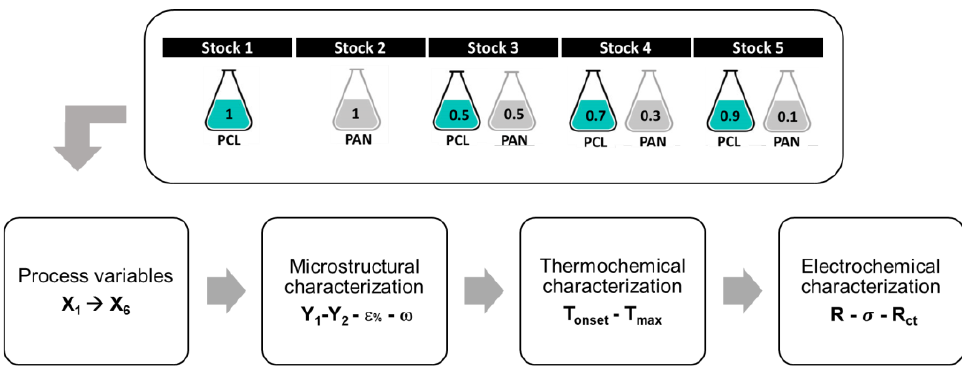
Figure 1. Experimental workflow, highlighting the selection of input variables and solutions with different PAN/PCL ratios for electrospinning manufacturing, as well as the selected output variables from the characterization of the membranes.